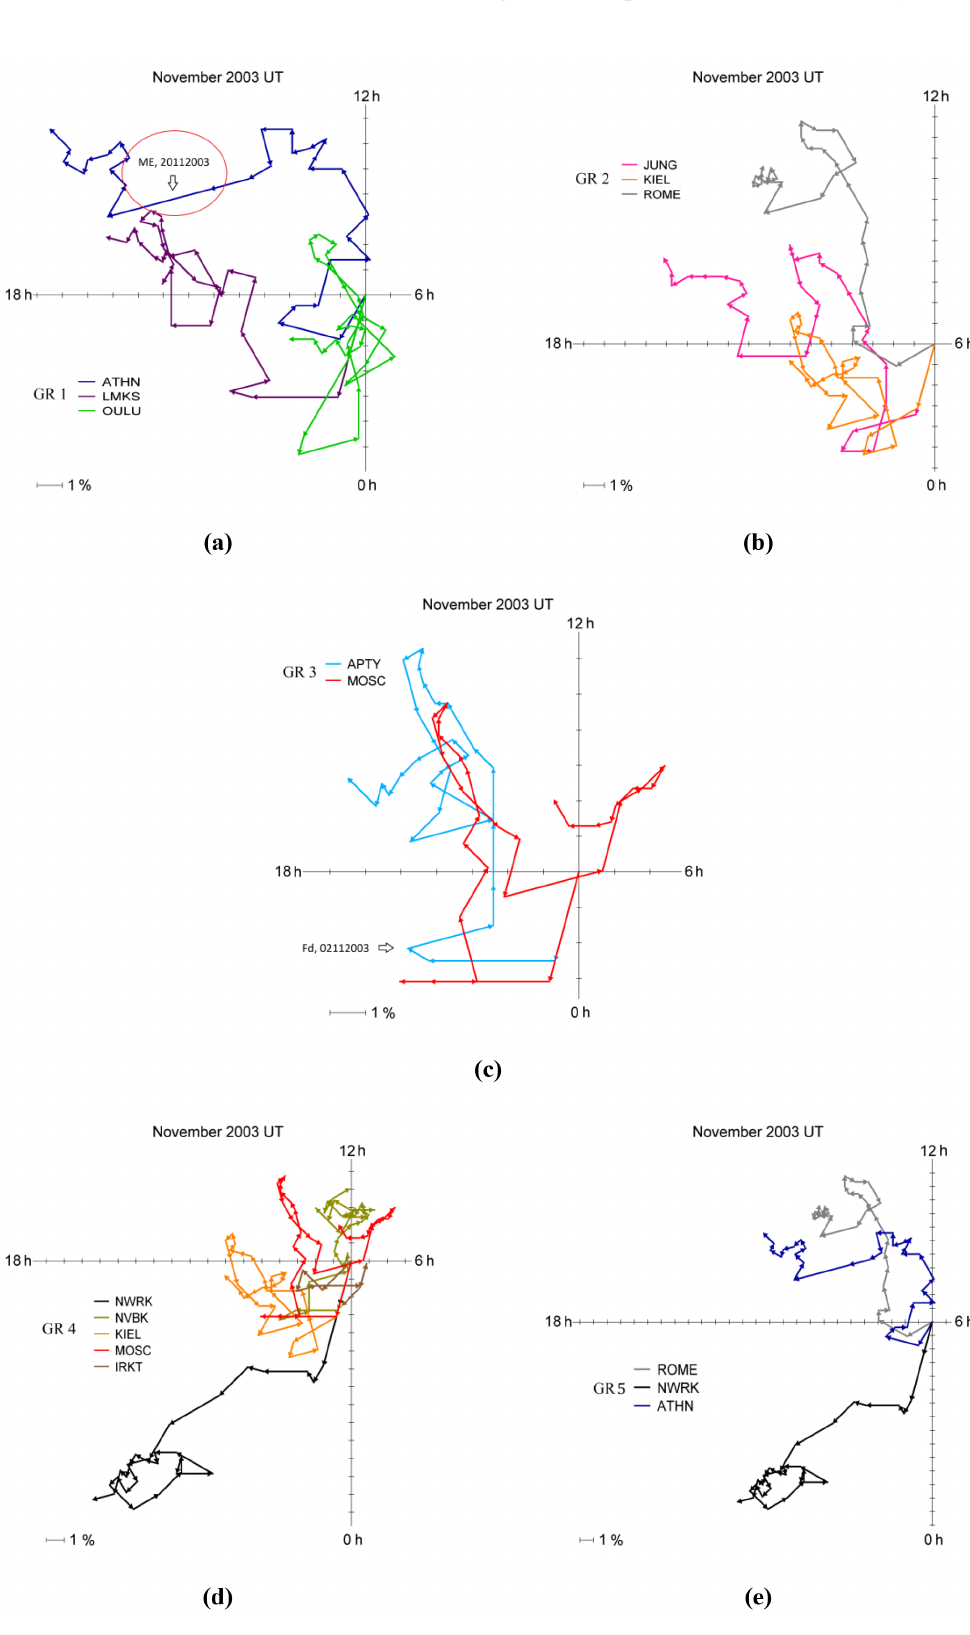
Figure 9. Daily diurnal vectors for all the groups of the stations for the month November